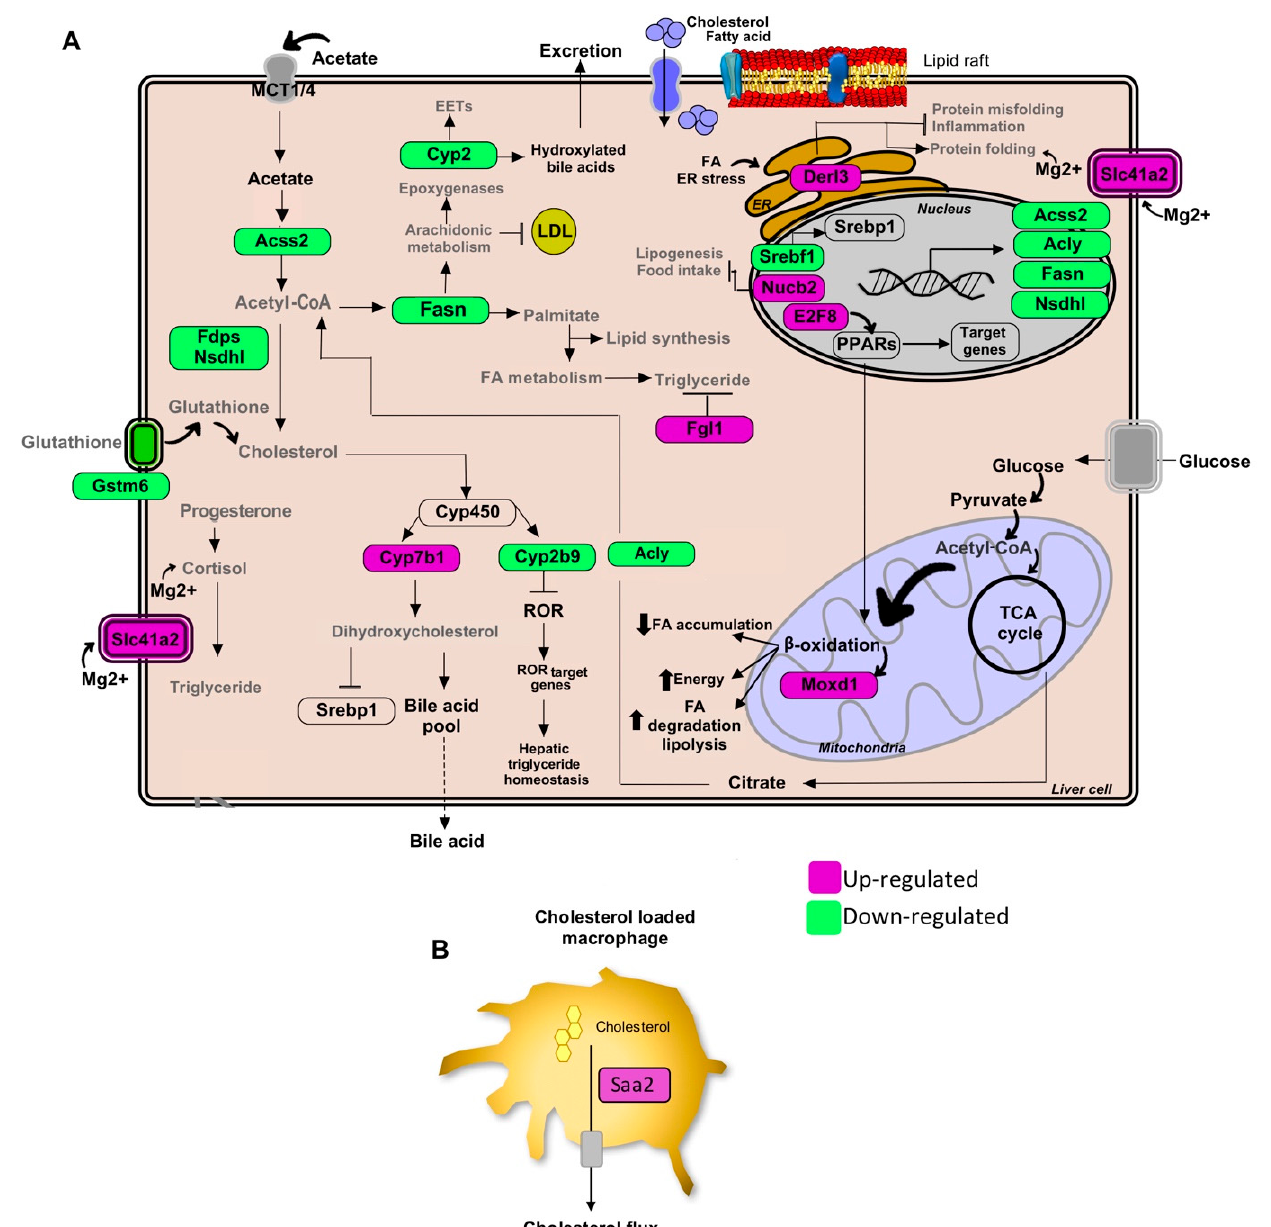
Figure 2. Pathways of lipid metabolism modulation in hepatic tissue by the Gl -1 extract of a Mexican strain of Ganoderma lucidum , under a high-cholesterol diet (HCD) given to C57BL/6 mice. ( A ) Lipid metabolic network and genes modulated by Gl -1 extract consumption. ( B ) Schematic outline of cholesterol efflux signaling in hepatic macrophages cells by the Saa2 gene. Green shaded boxes indicate significant down-modulation, while magenta shaded boxes indicate significant up-modulation of a gene in mice fed with a HCD and treated with Gl -1 extract versus mice fed with a HCD only. EETs: epoxyeicosatrienoic acids. ER: endoplasmic reticulum.